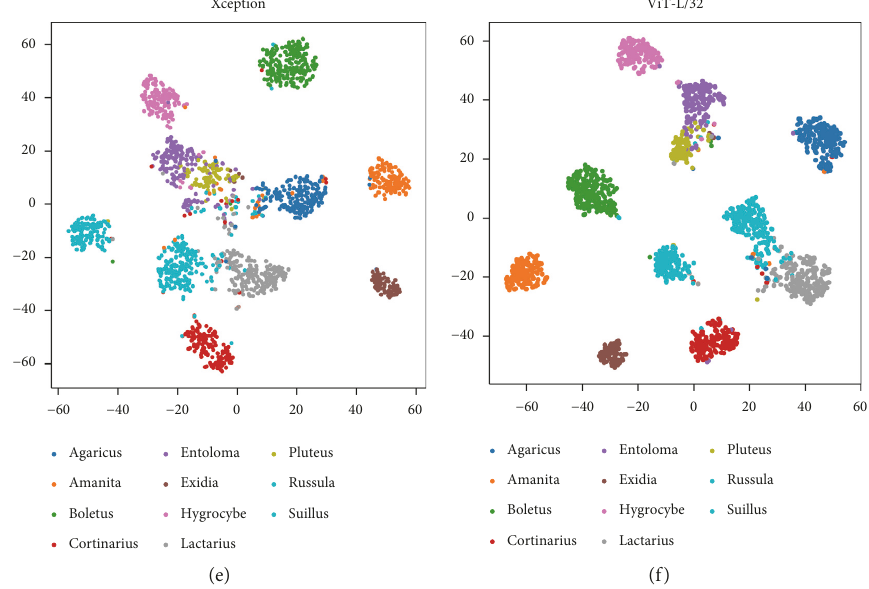
Figure 5: The t-SNE visualization. (a) VGG-16, (b) ResNet-34, (c) Inception-V3, (d) Inception-ResNet-V2, (e) Xception, (f)